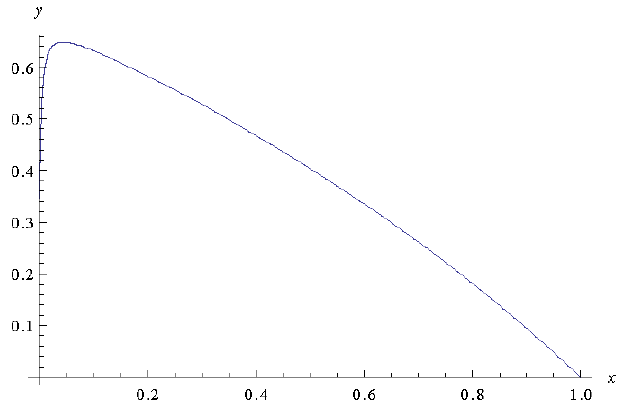
Figure 2. The approximate solution y for (cid:101) = 0.0001.